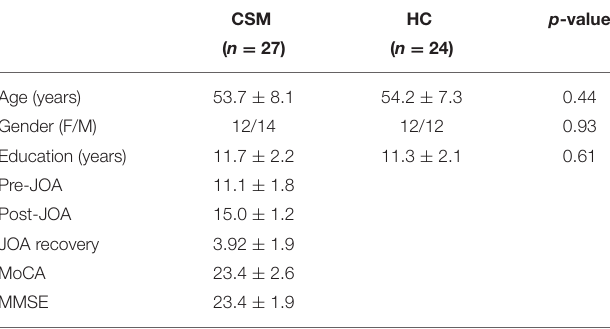
TABLE 1 | The demographic data study participants at